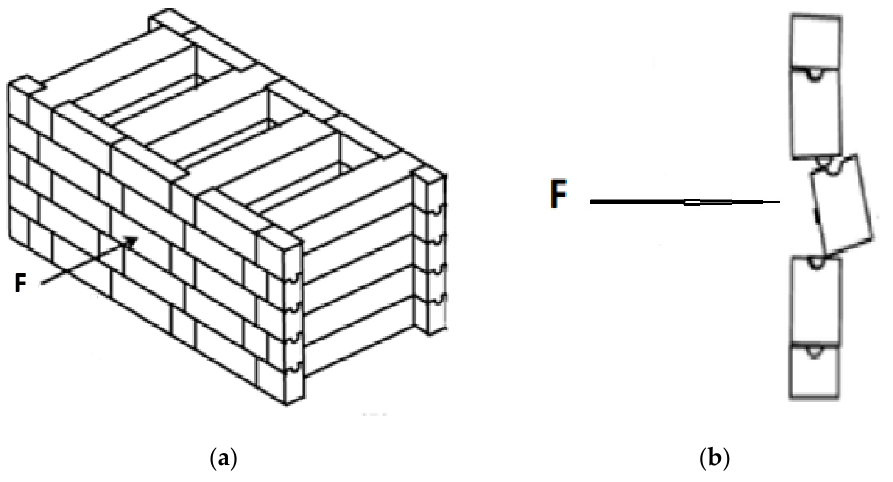
Figure 3. ( a ) Load exerted by the coke cake; ( b ) breakage of the oven wall.